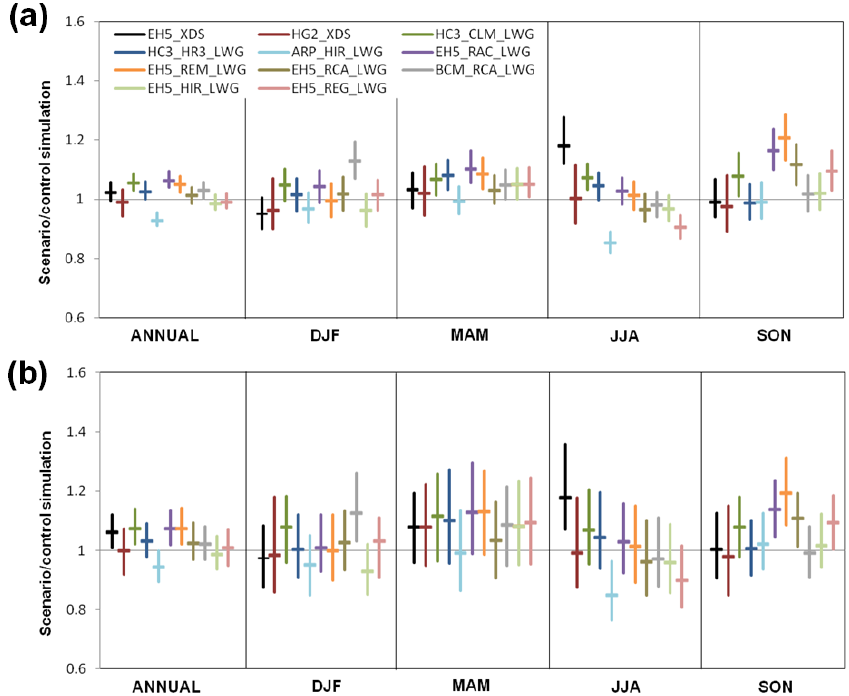
Fig. 6. Ratio between scenario (2071–2100) and reference (1971–2000) simulations for (a) 90th and (b) 99th percentiles. Vertical lines indicate 90% bootstrap confidence interval. The results are statistically significant when the ratio of 1.0 lies outside the 90% confidence interval. 24-h precipitation events averaged over the Lech catchment are shown.